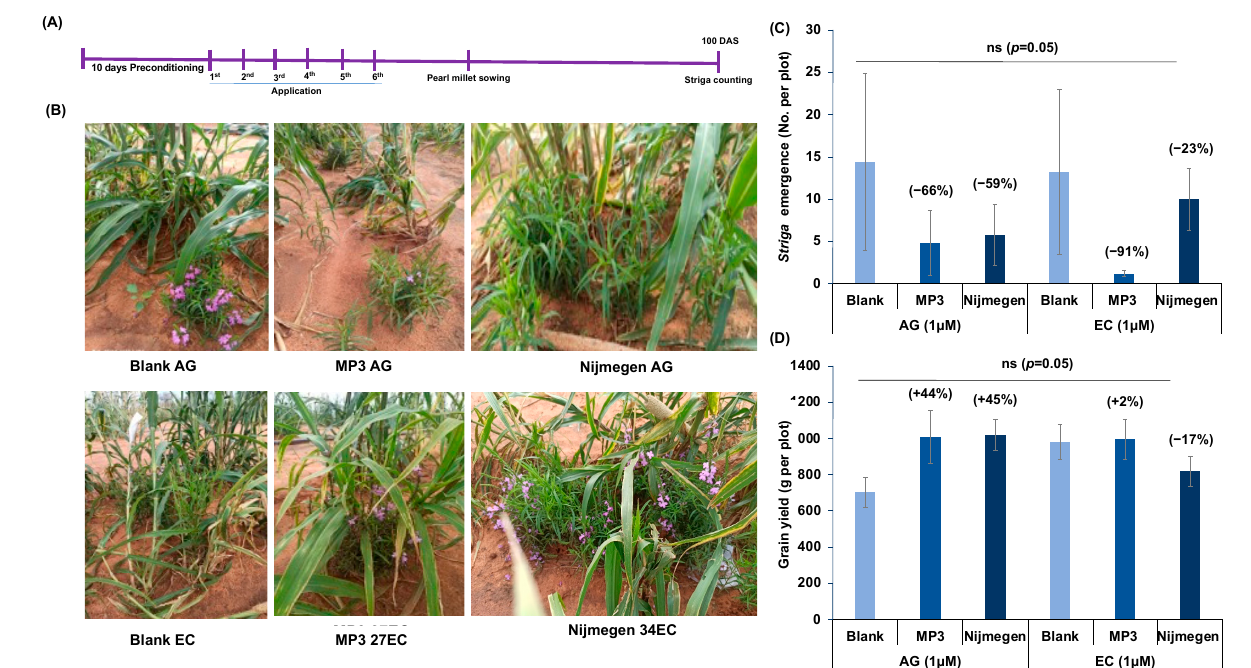
or decrease ( − ) over blank treatment. ns: non-significant.